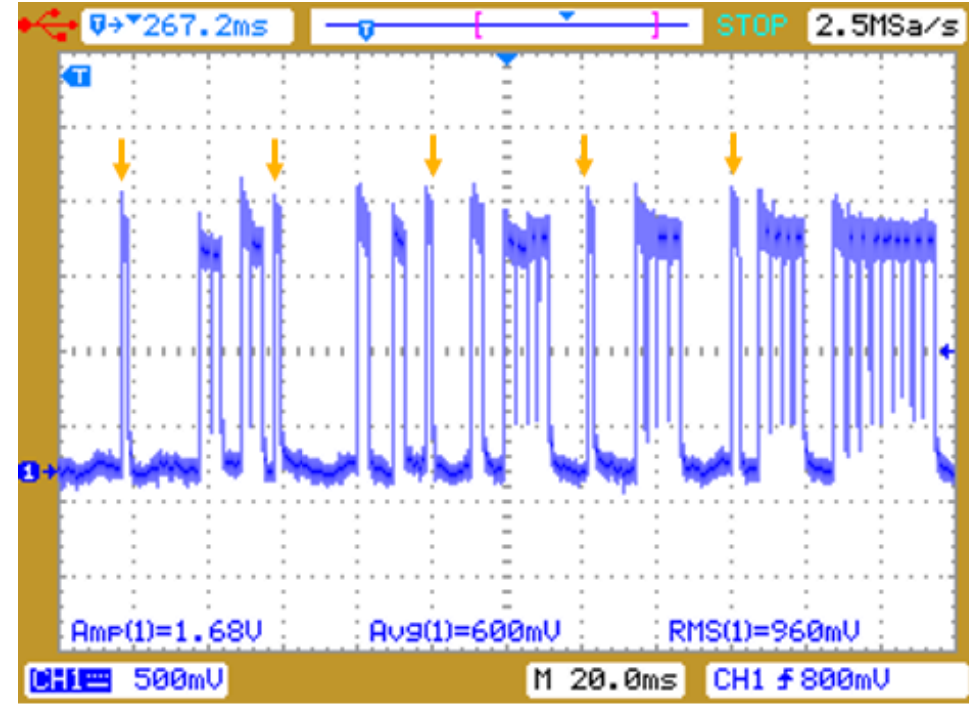
Figure 2. WiFi signal with traffic.